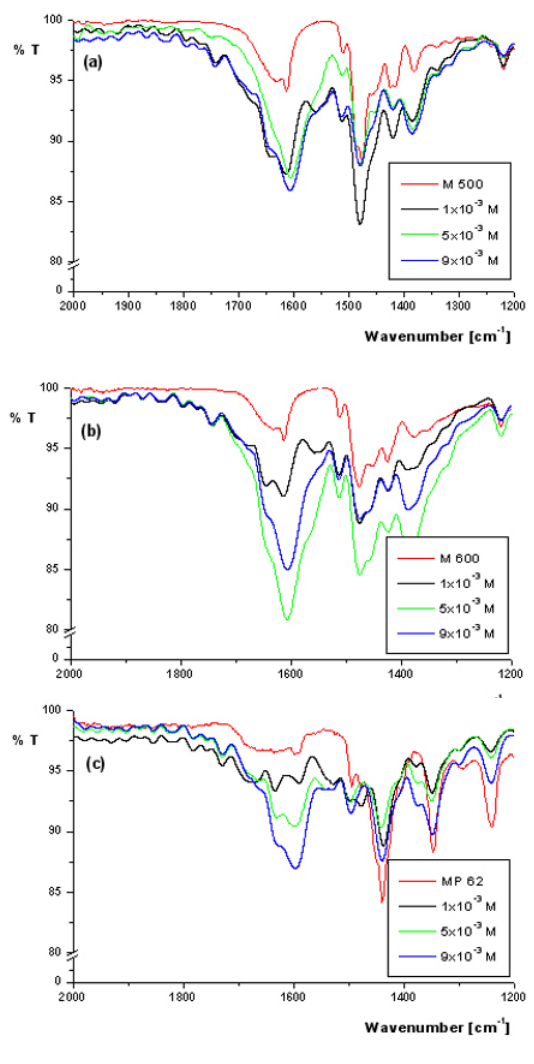
Figure 7. FT-IR spectra of Lewatit MonoPlus M 500 (a), Lewatit MonoPlus M 600 (b) and Lewatit MP 62 (c) before and after the sorption process of Cu(II) complexes with MGDA for different initial